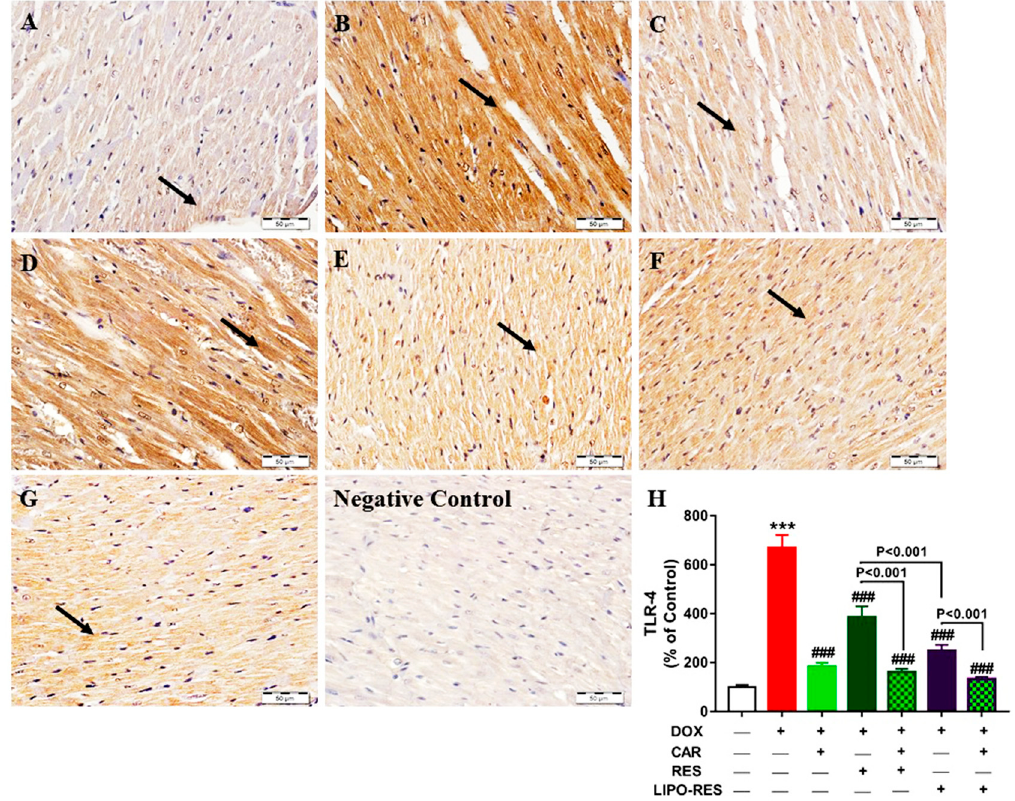
Figure 3. Photomicrographs of anti-TLR-4-stained LV sections in: ( A ) Control rats showing the absence of immune reaction in cardiomyocytes cytoplasm and nuclei (arrow); ( B ) DOX-intoxicated rats showing very strong immune positivity; ( C ) CAR-treated rats showing mild immune positive reaction; ( D ) RES-treated rats showing strong positive immune reaction; ( E ) CAR / RES-treated rats showing very mild immunostaining; ( F ) LIPO-RES-treated rats showing moderate immune reaction and ( G ) CAR / LIPO-RES-treated rats showing marked decrease in TLR-4 immune reactivity. ( H ) Mean ± SEM of TLR-4 immunostaining in LV sections of di ff erent groups, ( n = 6). *** p < 0.001 versus Control and ### p < 0.001 versus